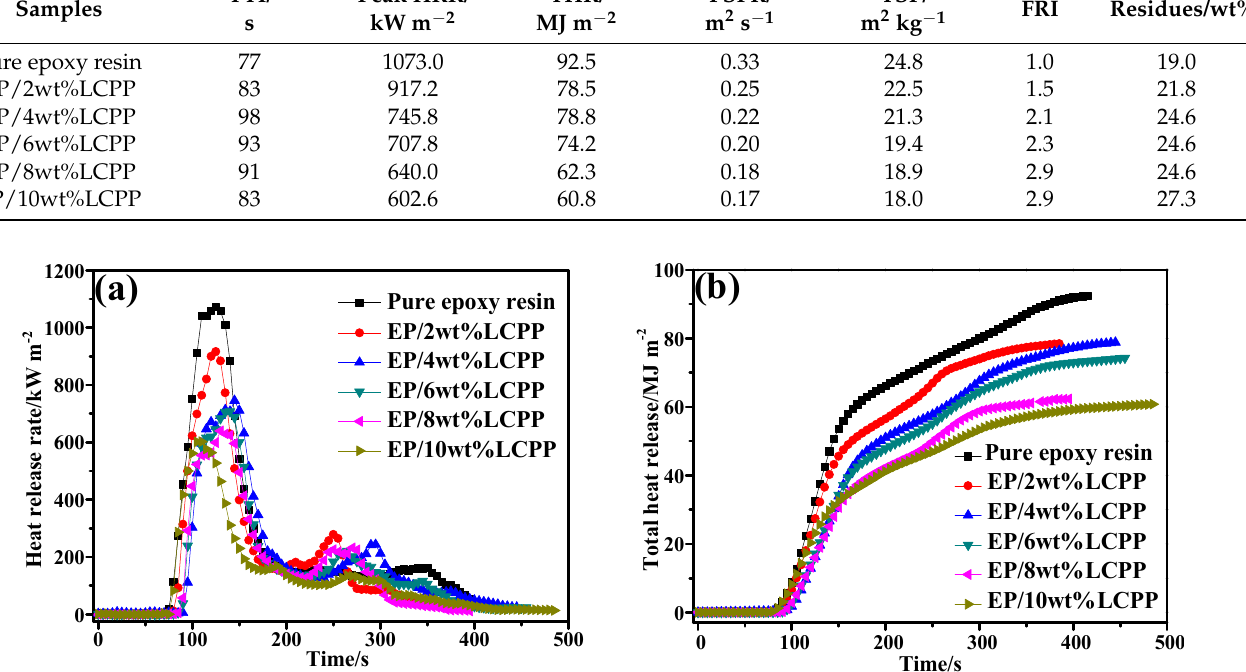
Figure 4. Heat release of pure EP and the EP/LCPP composites; ( a ) HRR profiles; ( b ) THR profiles.